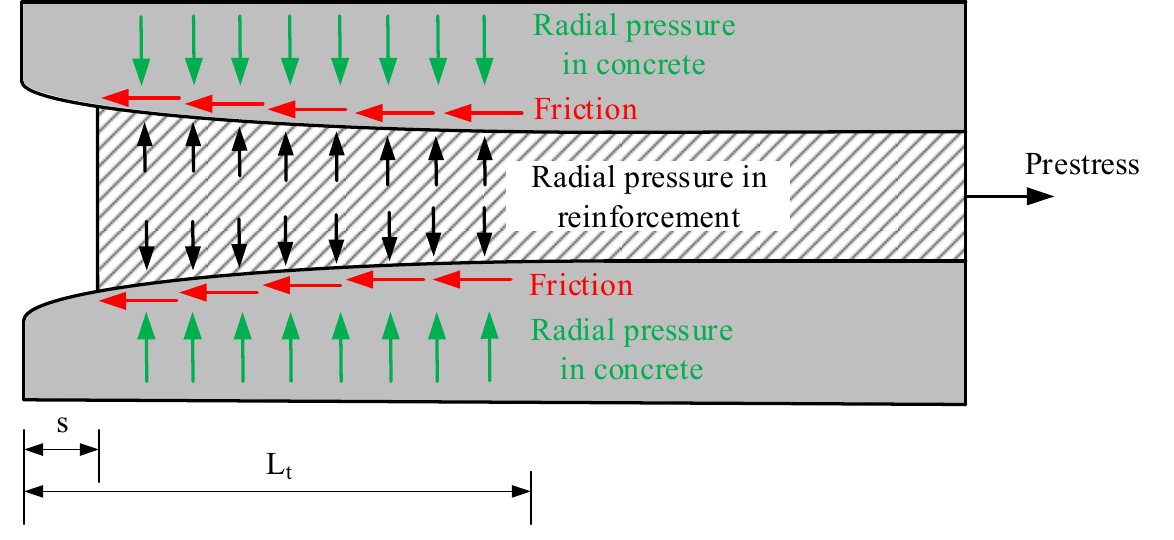
Figure 1. Mechanism of pretensioned reinforcement release.